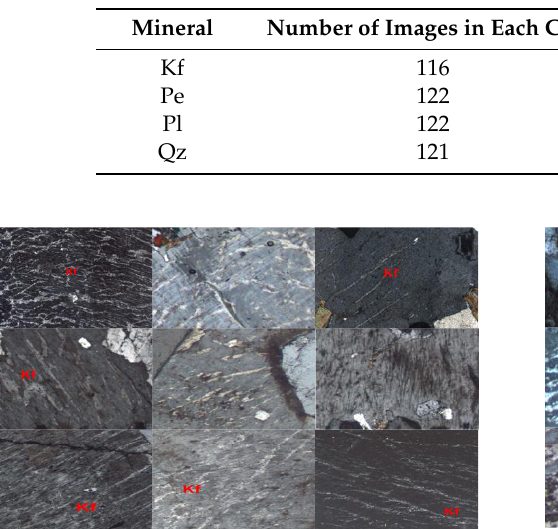
Figure 8. The feature map visualization of Kf.